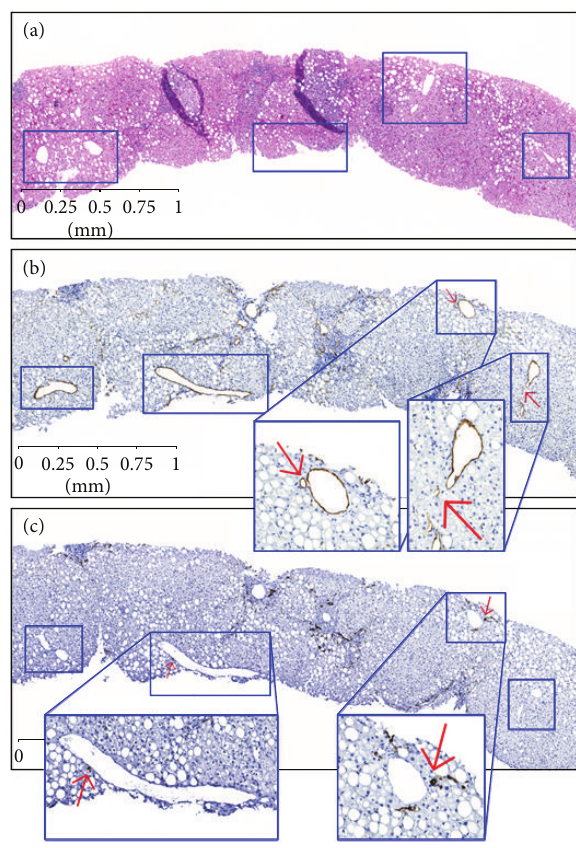
Figure 1: (a) Low magnification view of steatotic HCV liver biopsy with 4 central zones marked by squares (H&E, × 50). (b) Level section of the same liver biopsy demonstrates two central zones with microvessel and sinusoidal capillarization. In this case, the 𝑀 score is 2/4 = 0.5. Insets: high magnification of microves- sel/sinusoidal capillarization highlighted by CD34 immunostain and arrows (CD34, × 50; insets: CD34, × 200). (c) Level section of the same liver biopsy demonstrates two central zones with ductular reaction and intermediate-phenotype hepatocytes (CK7, × 50). In this case, the 𝐷 score is 2/4 = 0.5. Insets: high magnification of ductular reaction/intermediate-phenotype hepatocytes highlighted by CK7 immunostain and arrows (CK7, × 50; insets: CK7, ×